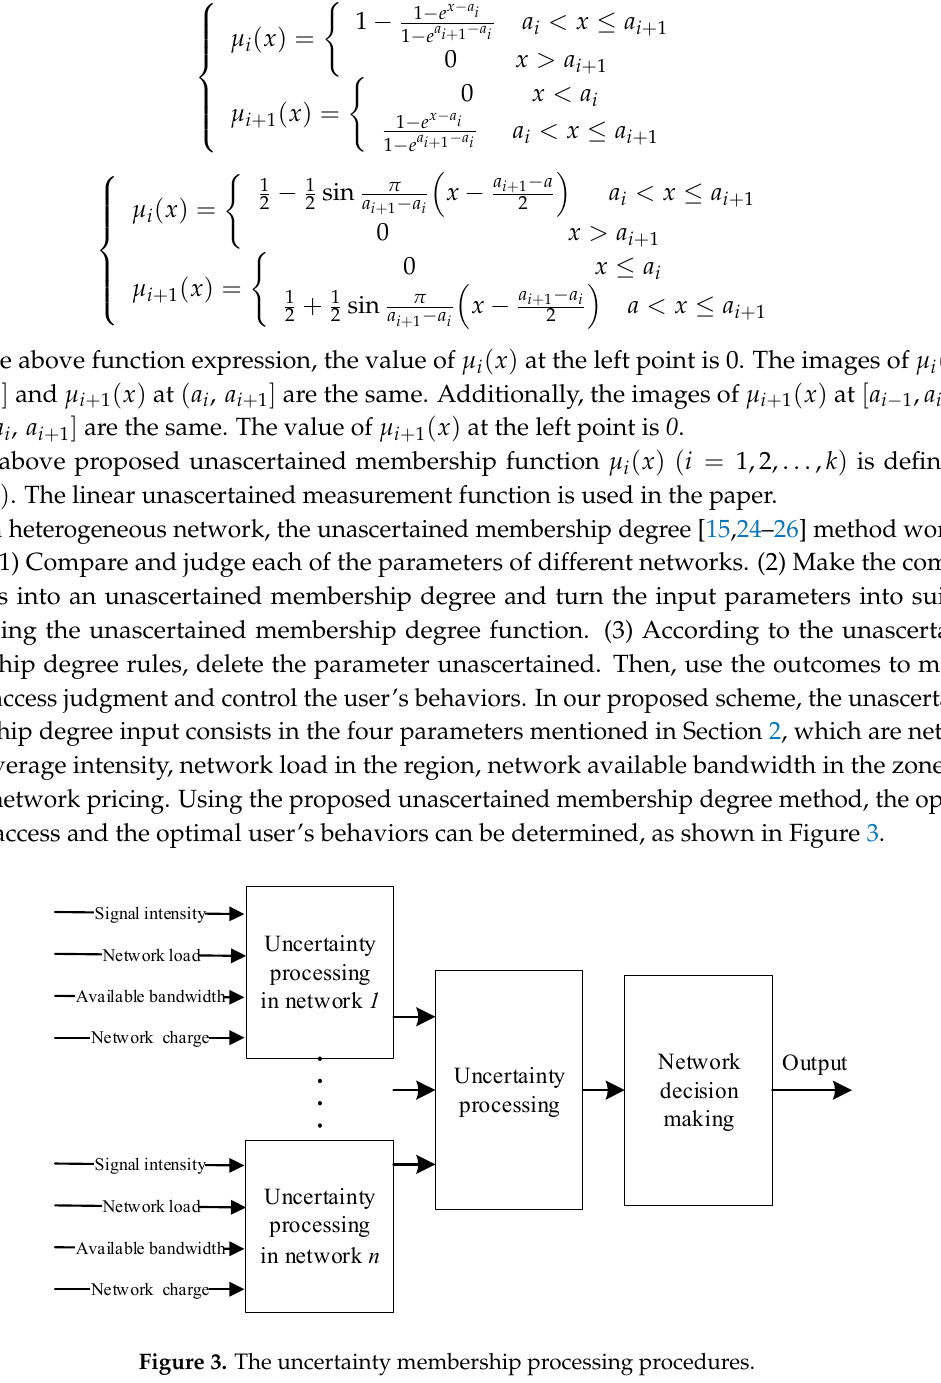
Figure 4. ( a ) Cellular network signals membership function; ( b ) WLAN (wireless local area network) receiving signals membership function; ( c ) network traffic membership function; ( d ) collect fees membership function; ( e ) cellular network load membership function; ( f ) WLAN load membership function.